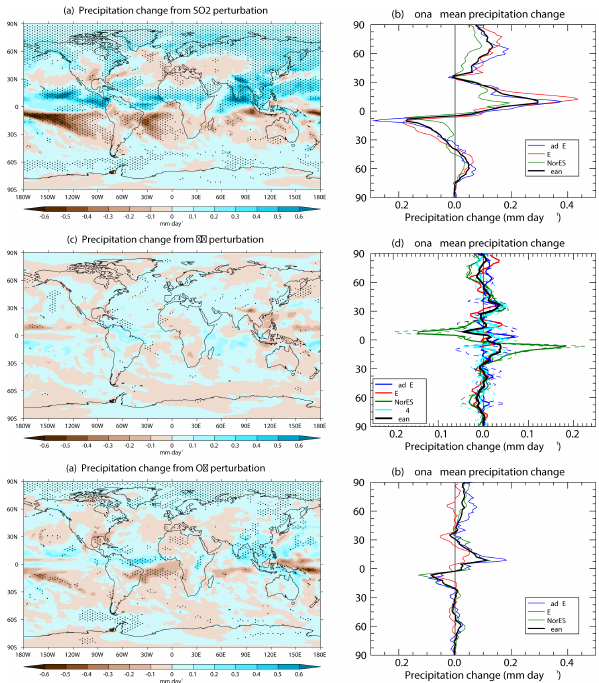
Figure 6. Annual average change in all-sky TOA SW flux for (a, b) SO 2 , (c, d) BC and (e, f) OC perturbations. Left column: multi- model mean maps. Right column: zonal mean. In (a, c, e) , stippling shows points where the response is significant at the 95% level.